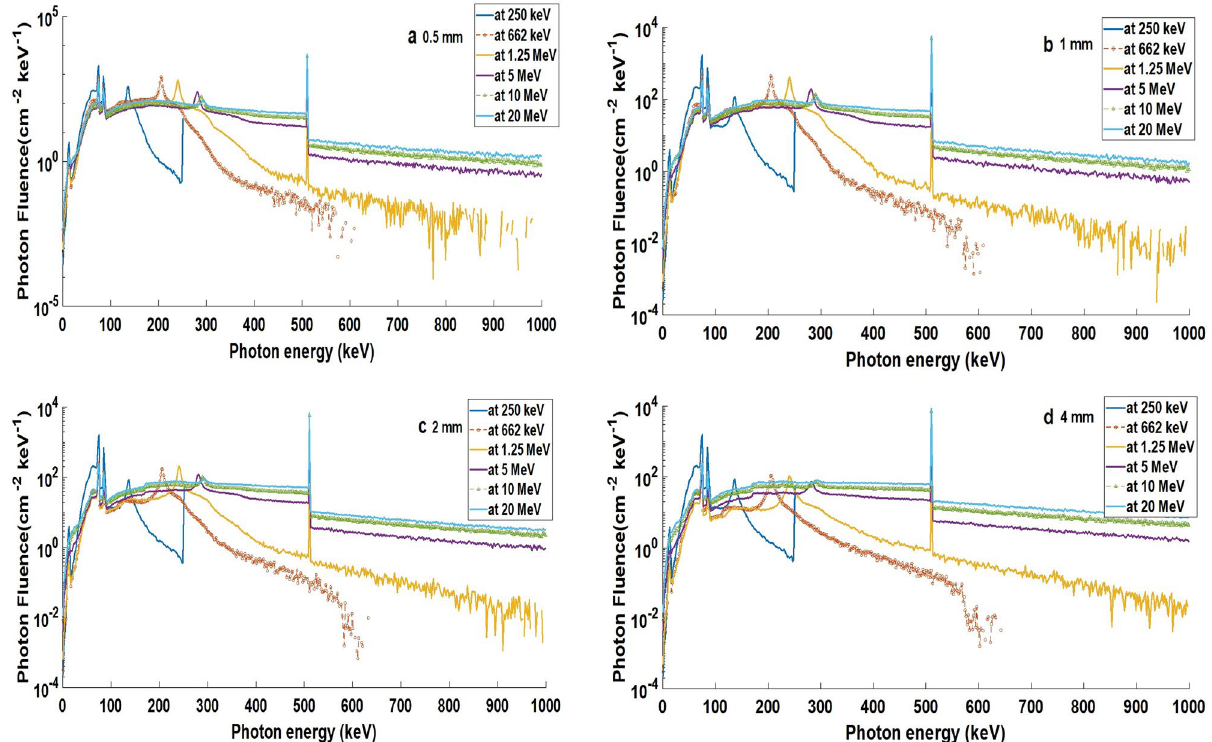
Figure 3. The fluence spectra of backscattered photons of various energy for ( a ): 0.5 mm, ( b ): 1 mm, ( c ): 2 mm, and ( d ): 4 mm Pb layered over the ordinary concrete at a reflection angle of